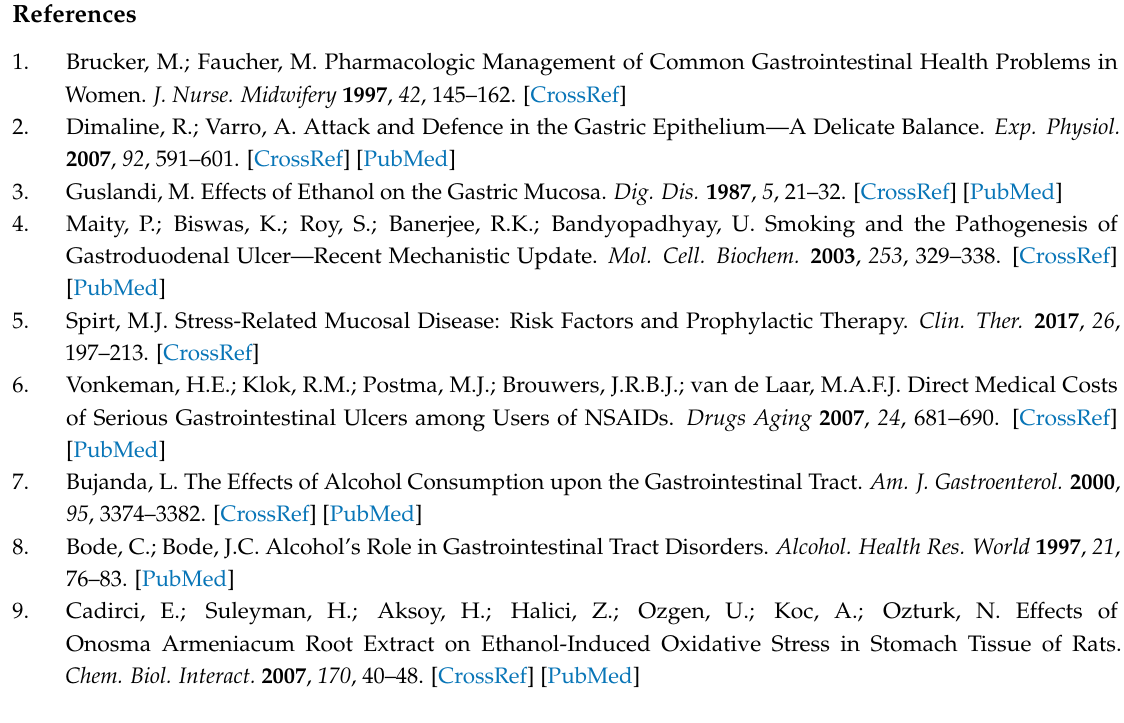
Table S1: Additional proteins identified by